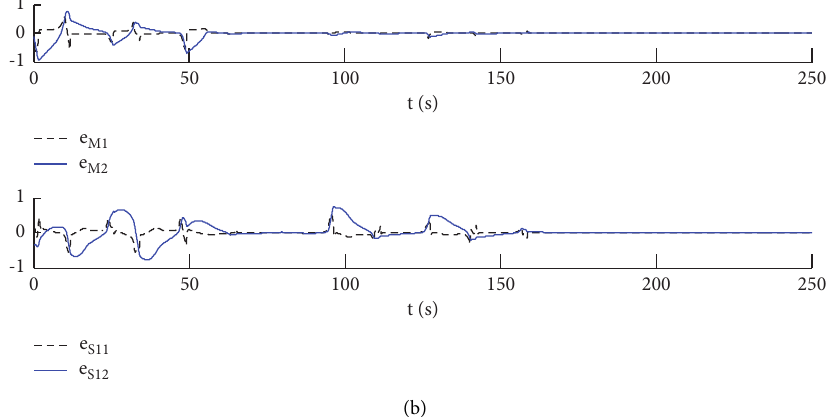
Figure 6: (a) Errors between the corresponding states of master and (b) master observer and slave observer for Theorem 1. Table 1: DOS for different values of Lm � Ls and fixed F � [1 0]. Serial no. L m � L s